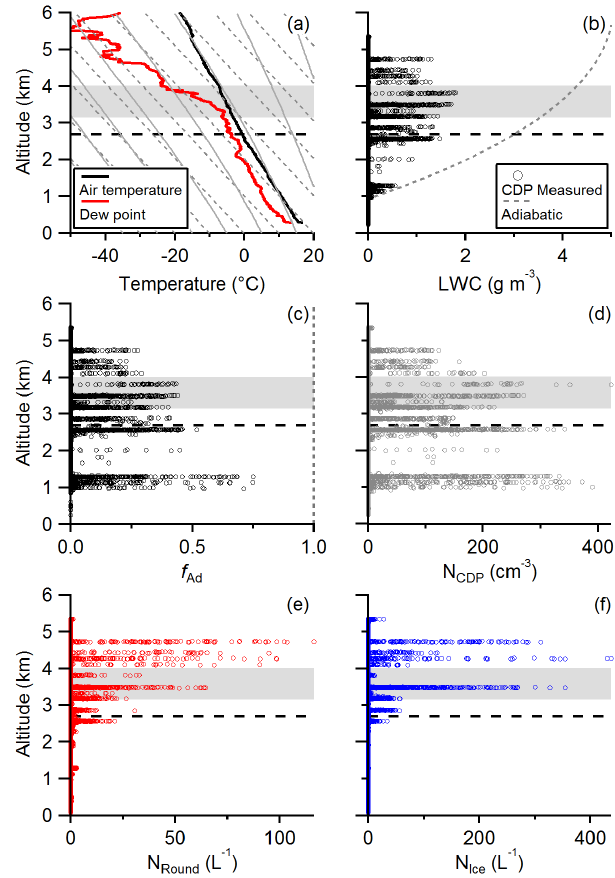
Figure 3. Vertical profile showing radiosonde data and cloud mea- surements made by the BAe-146. The horizontal dashed lines mark the 0 ◦ C level, and the shaded region shows the H–M tempera- ture zone. Panel (a) shows temperature and dew point from the 15:00UTC radiosonde launched from Davidstow. The solid and dashed grey lines are wet pseudo adiabats and dry adiabats, respec- tively. Panel (b) shows the LWC measured by the CDP, as well as the calculated adiabatic values. These data are converted to the adia- batic fraction, f Ad in panel (c) . Panel (d) shows the droplet concen- tration measured by the CDP, and panels (e) and (f) show the round and ice concentrations measured by the 2DS. In this plot only, edge particles measured by the 2DS are assigned to the round category for T ≥ 0 ◦ C, and the ice category